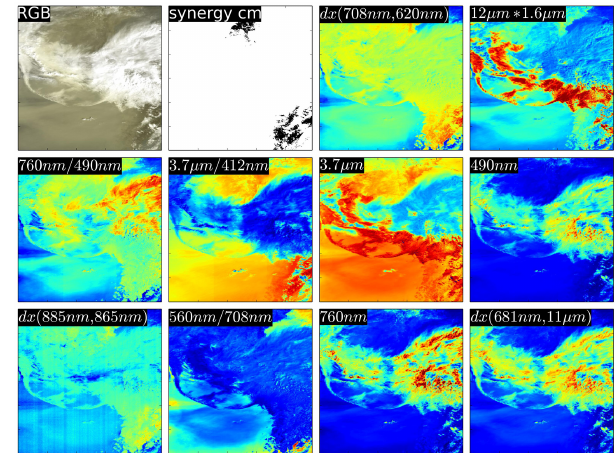
Figure 2. Similar to Fig. 1 but for a scene near the Korean penin- sula. The center of the images is located at 125 ◦ 52 (cid:48) 12 (cid:48)(cid:48) E and 37 ◦ 45 (cid:48) 36 (cid:48)(cid:48)